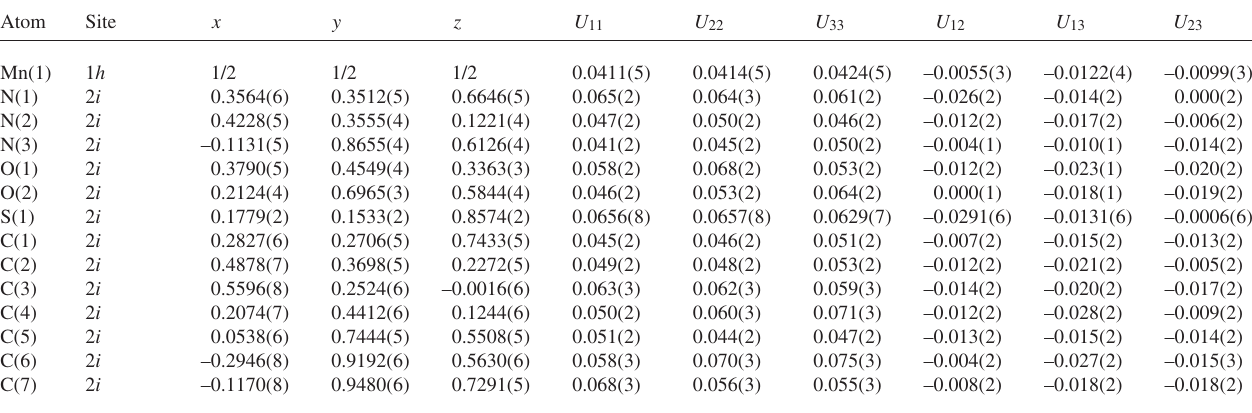
Table 3. Atomic coordinates and displacement parameters (in Å 2 )